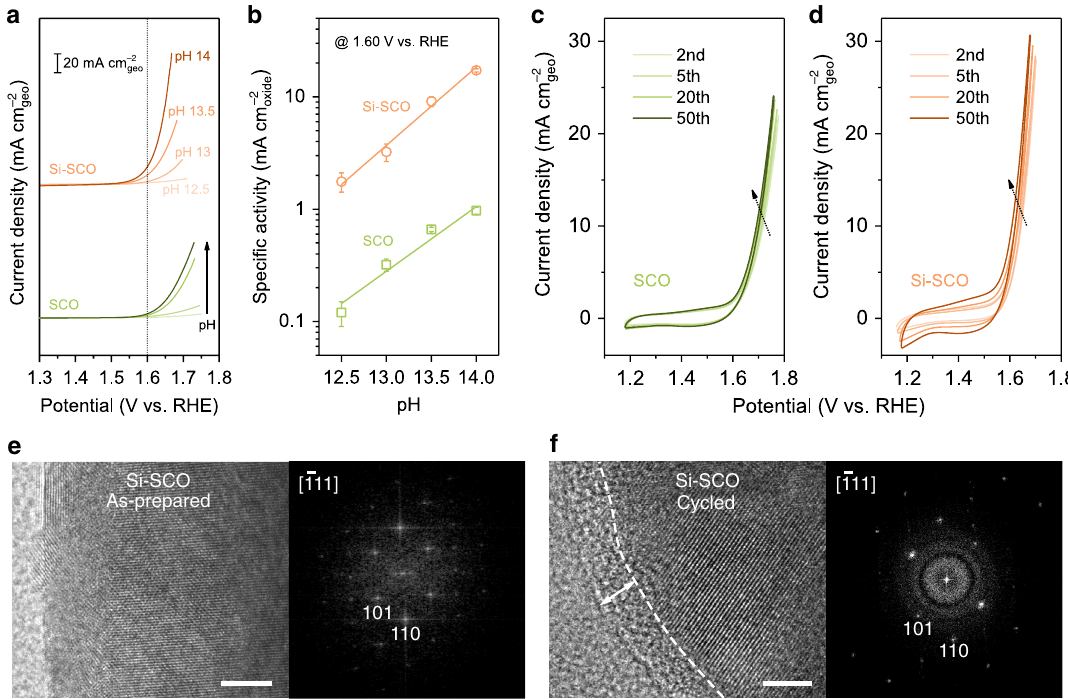
Fig. 3 The oxygen evolution mechanism studies on Si-incorporated strontium cobaltites. a OER kinetic currents (in mA cm − 2 geo ) of SCO and Si – SCO in O 2 -saturated KOH electrolytes with varying pH. b OER speci fi c activity (in mA cm − 2 oxide ) of SCO and Si – SCO at 1.60 V vs. RHE as a function of pH. c , d Select CV curves of c SCO and d Si – SCO in O 2 -saturated 0.1 M KOH over 50 cycles at a 10 mV s − 1 scan rate. e , f HRTEM images and the corresponding FFT patterns of e as-prepared and f cycled (for 50 cycles) Si – SCO electrode. Scale bar in e and f is 5